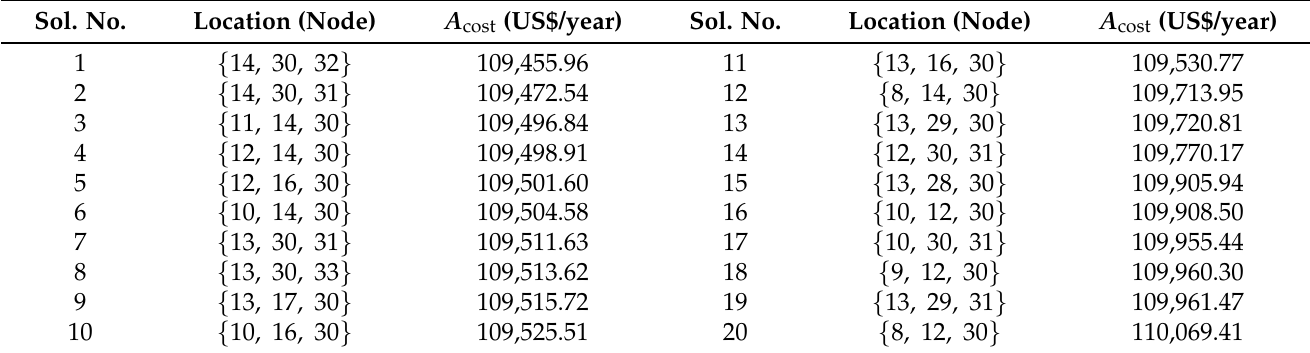
Table 5. Best solutions found by the proposed CBGA-SOCP approach with a population size of 20. Sol. No.